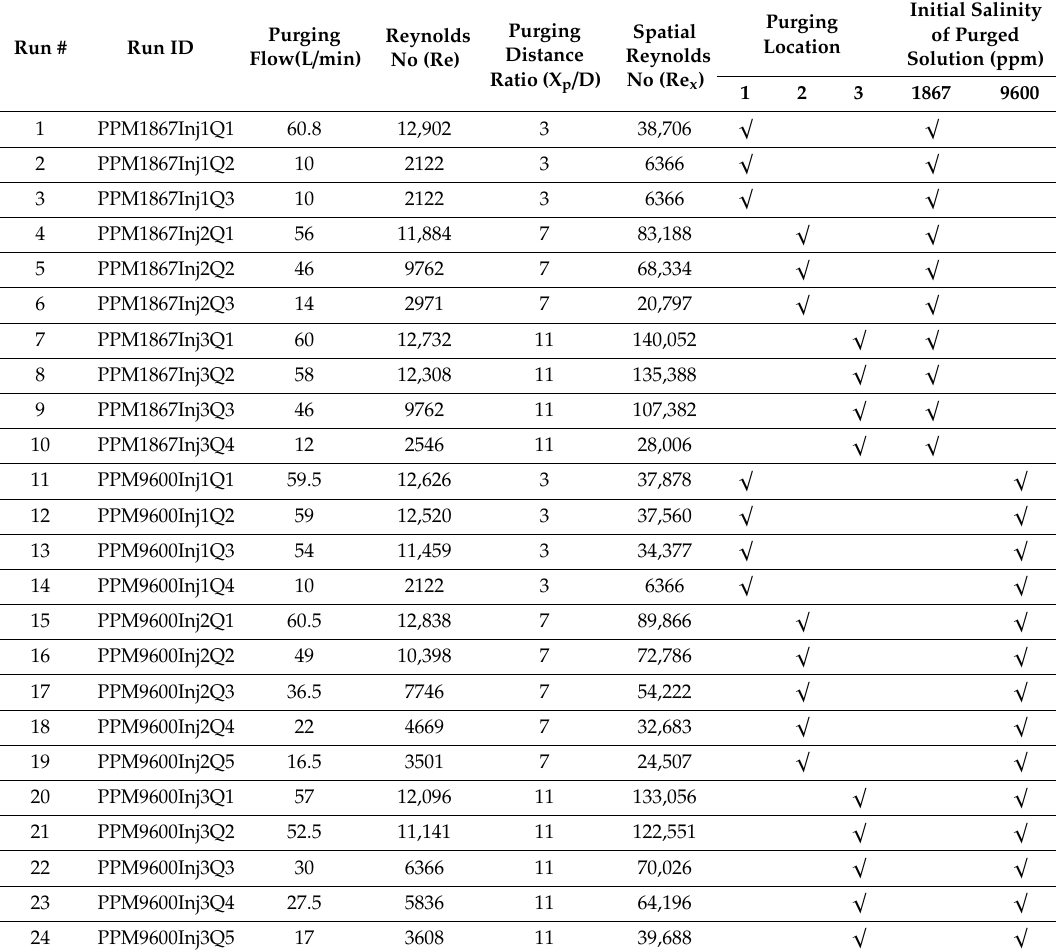
Table 2. Characteristics of the Conducted Experimental